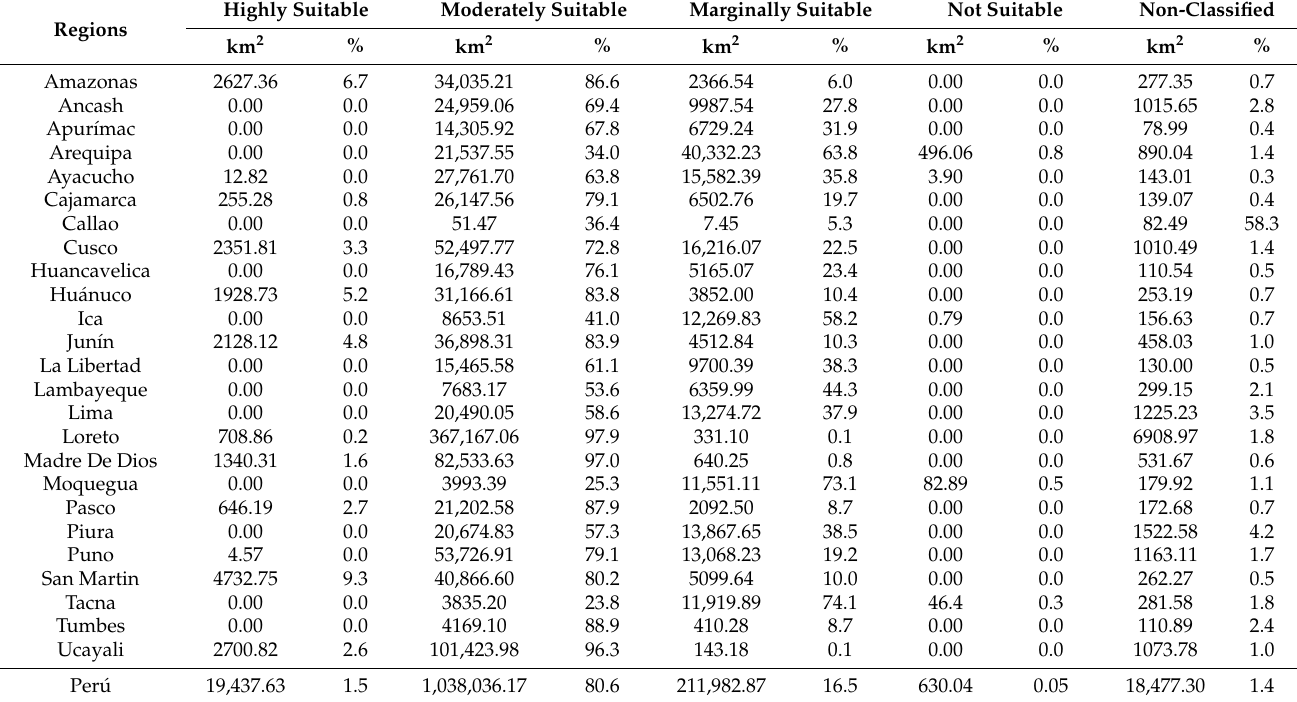
Table A2. Land suitability for cocoa cultivation in Peruvian regions, AHP model. Regions